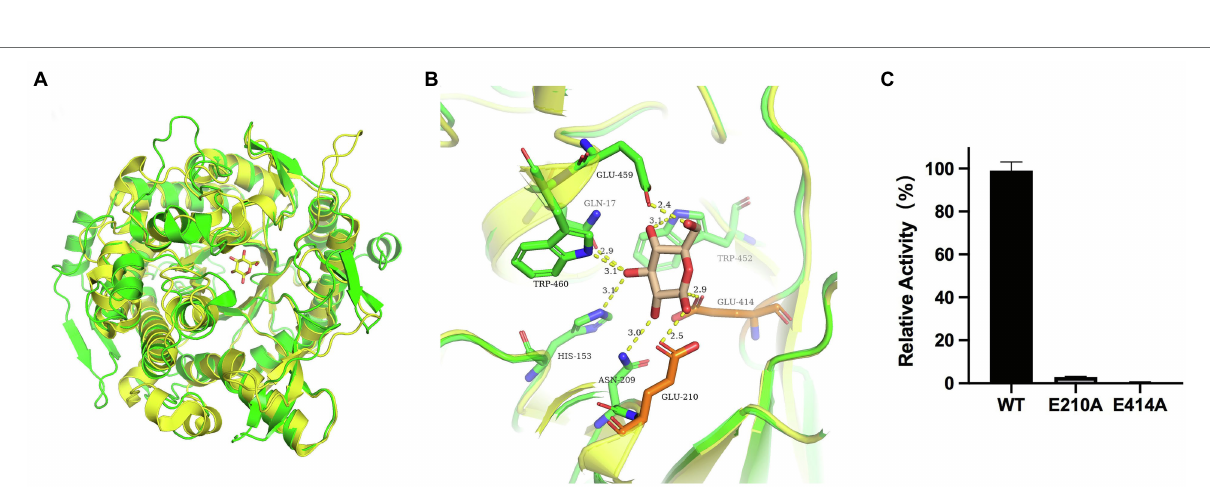
FIGURE 6 | Structural comparison of GH1 at subsite-1. (A) Structural comparison of TsBGL (green) with Td2F2 (yellow, PDB: 5AYI, RMSD = 0.909. (B) Superposition of the active sites of TsBGL (green) and Td2F2 (yellow). The product of glucose was shown in wheat sticks. (C) Hydrolysis activity of TsBGL and active site mutants using p NPGlc as the substrate.